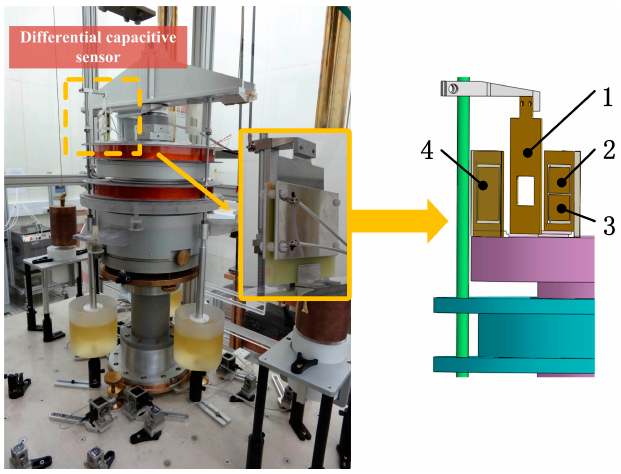
Figure 6. Experimental setup in Joule balance. 1 . Grounded shield window; 2 , 3 . High-voltage plates; 4 . Low-voltage plate.